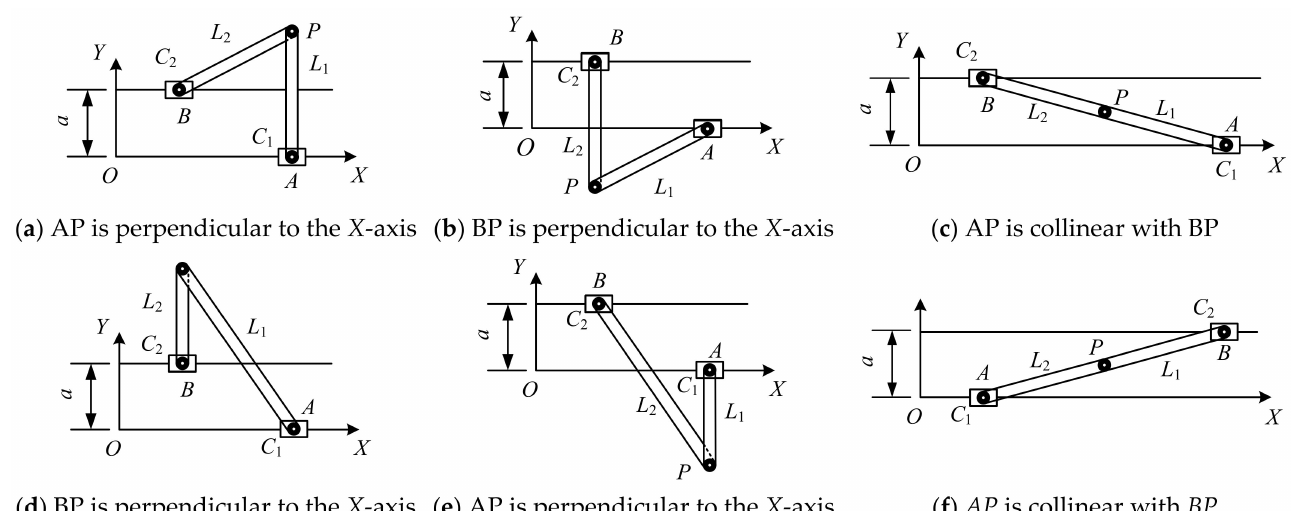
Figure 8. Singularity configuration of parallel